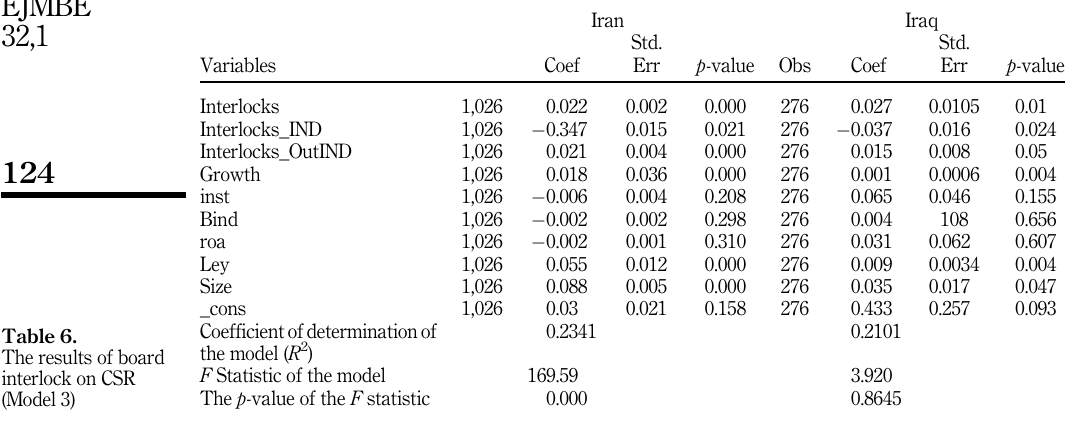
Table 6. The results of board interlock on CSR (Model 3)